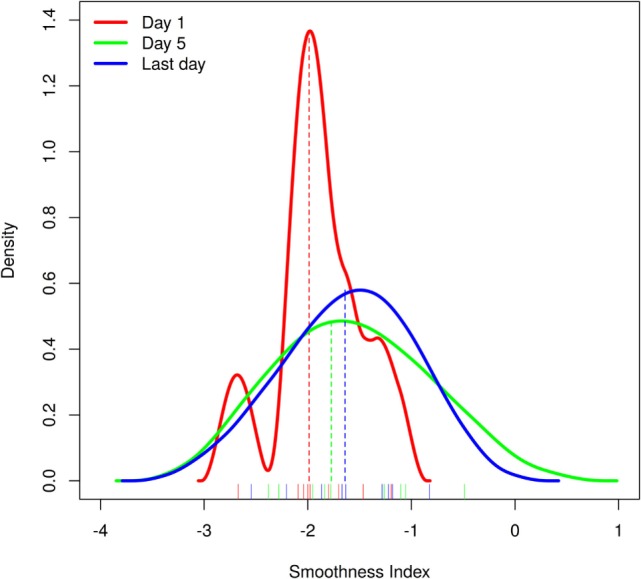
Movement smoothness at day 1, day 5, and the last day of the intervention was compared in the treatment group (MG) patients and found to be significantly better after the therapy. Shown here are the kernel density estimates of the MG smoothness measures at day 1 (red line), day 5 (green line), and the last day of the intervention (blue line; see Materials and Methods and Results for details) with the smoothness index shown on the x-axis and the density estimation on the y-axis. Medians of the corresponding distribution are depicted as dashed lines in corresponding color.